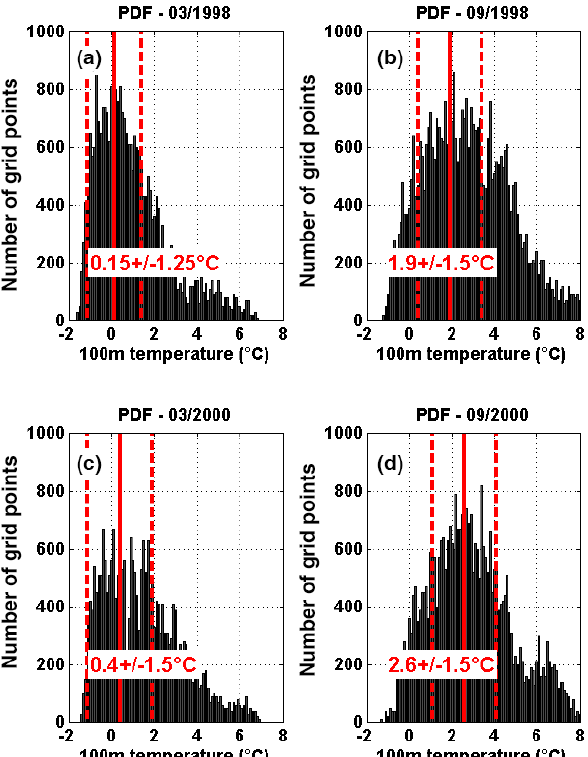
Figure 11. Probability density functions (PDFs) of the temperature fields (the period is indicated above each panel).